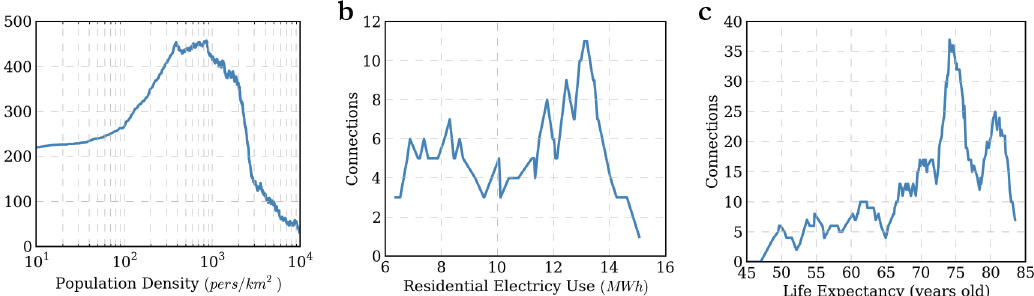
Fig 3. Application of Network-Based Methodology on Three Real-World Data Sets. (A) Chicago Metropolitan Statistical Area population density for 2,207 census tracts, where we used a log-scale because of the heterogeneity in the data (Source: 2010 US Census). (B) 2012 residential electricity use for the 50 US states and the District of Columbia (Source: EIA). (C) 2012 world life expectancy for 199 countries (Source: World Bank). See Section F in S1 File for details on each data set.